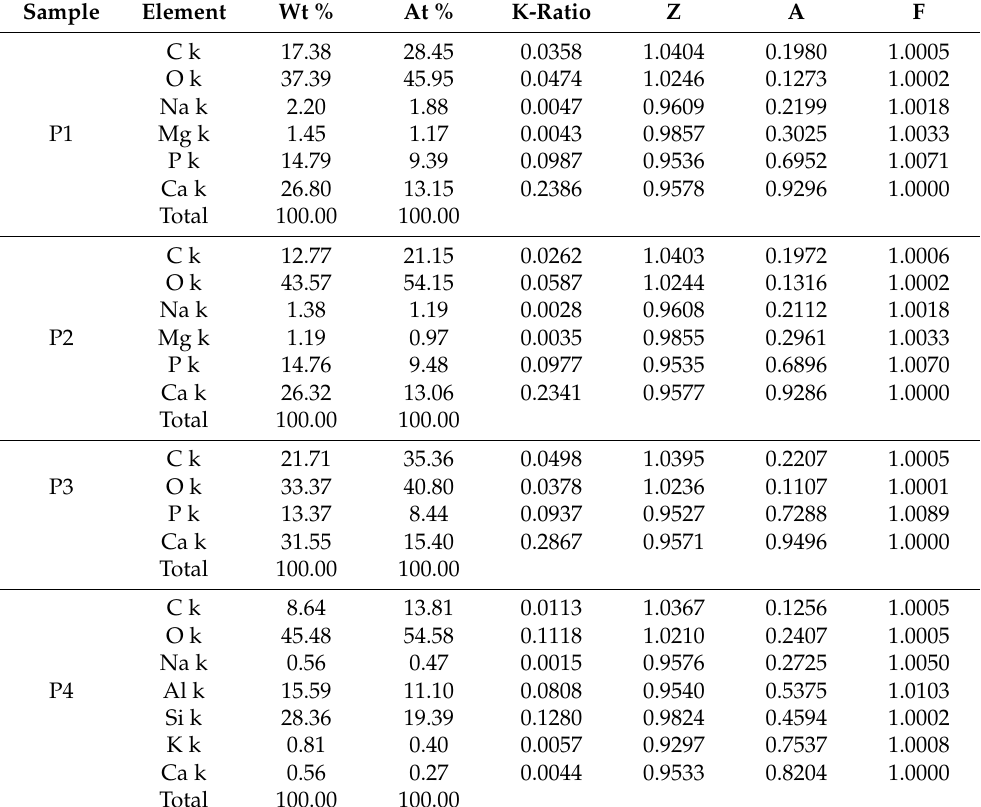
Table 2. Elemental composition of test